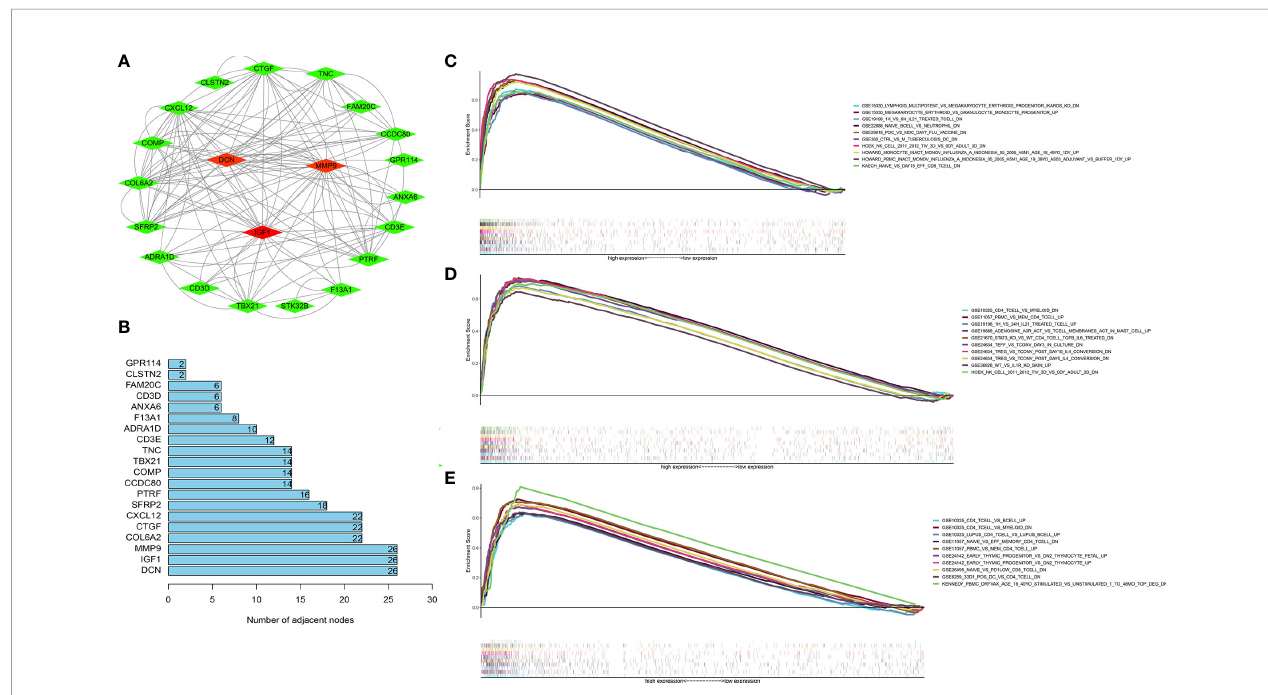
FIGURE 6 | GSEA enrichment analyses of the hub genes. (A) The PPI network of 45 PRDEGs (coef fi cients > 0.15). (B) DCN, MMP9, and IGF1 had the most nodes in the PPI network. (C – E) The GSEA enrichment analyses of IGF1 (C) , MMP9 (D) , and IGF1 (E) .